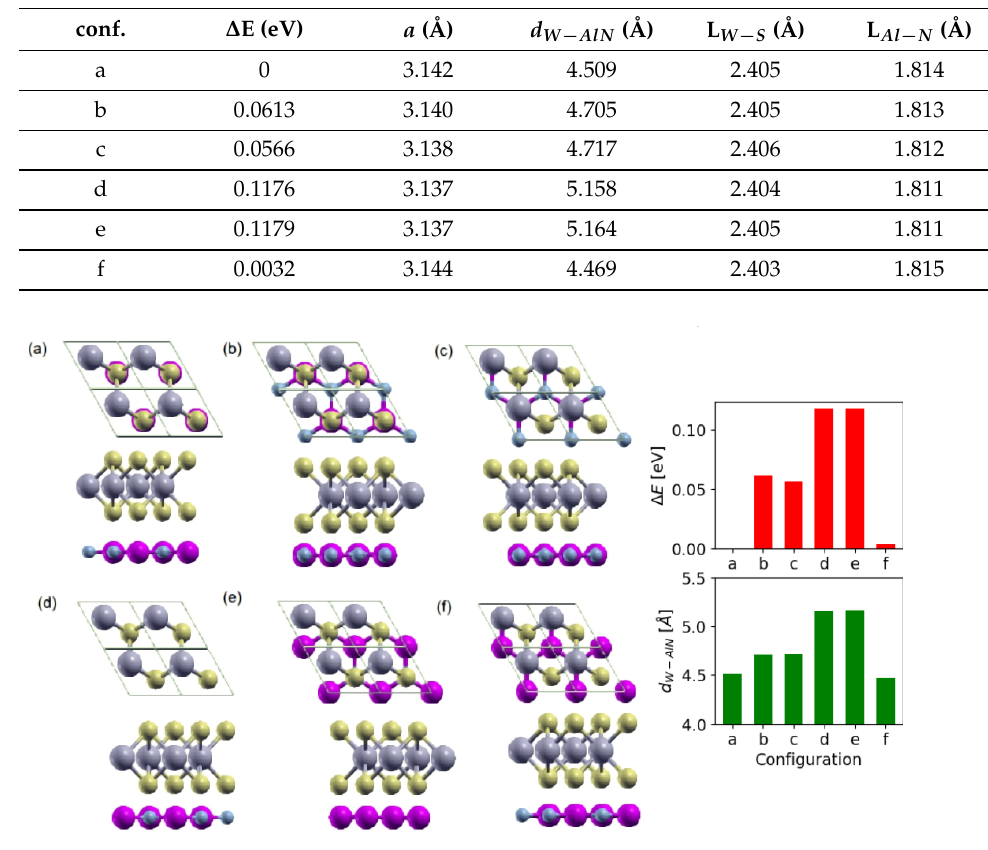
Figure 1. Top and side views of AlN / WS 2 heterostructures in different rotation angles: ( a ) 0 ◦ , ( b ) 60 ◦ , ( c ) 120 ◦ , ( d ) 180 ◦ , ( e ) 240 ◦ and ( f ) 300 ◦ . Small light-blue balls indicate N atoms, Al atoms are in violet and gray and yellow indicate W and S atoms, respectively. On the right, we report the energy of each configuration with respect to the (a) one and the distance d W − AlN